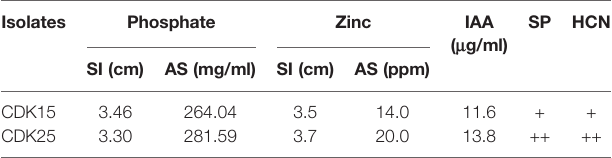
TABLE 1 | Plant growth-promoting traits of selected bacterial isolates. Isolates